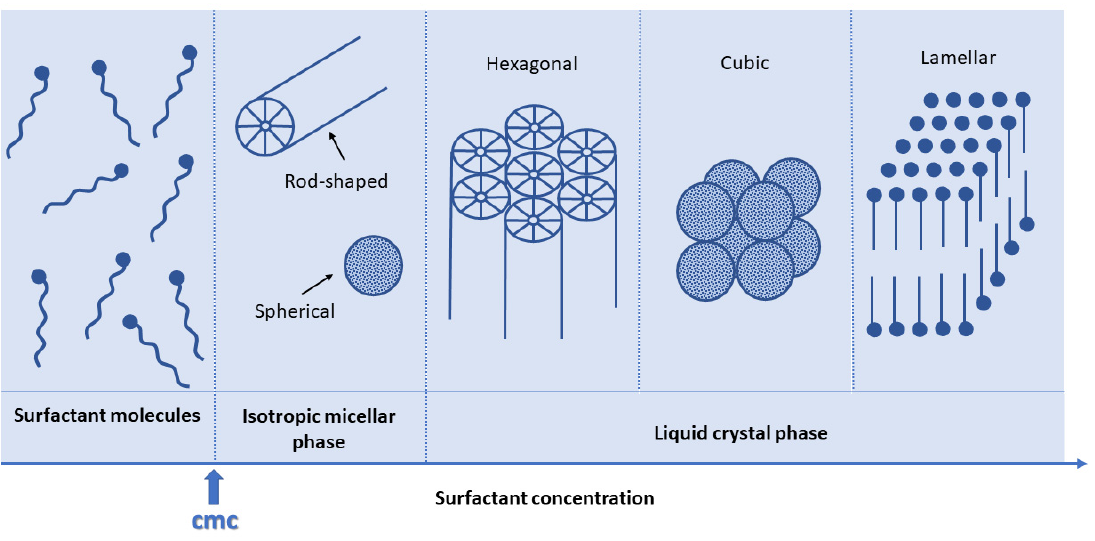
Figure 3. Phase sequence of a water–surfactant binary system following surfactant concentration [12].